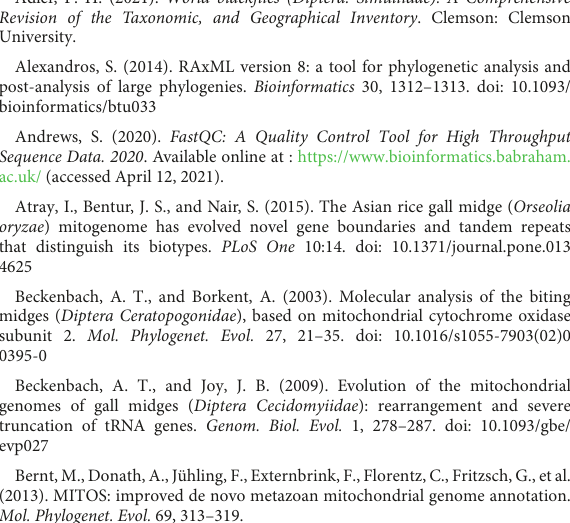
FigTree (2021). FigTree Evolution Phylogenetics and Epidemilogy . Available online: http://tree.bio.ed.ac.uk/software/figtree/ (accessed on Apr 12